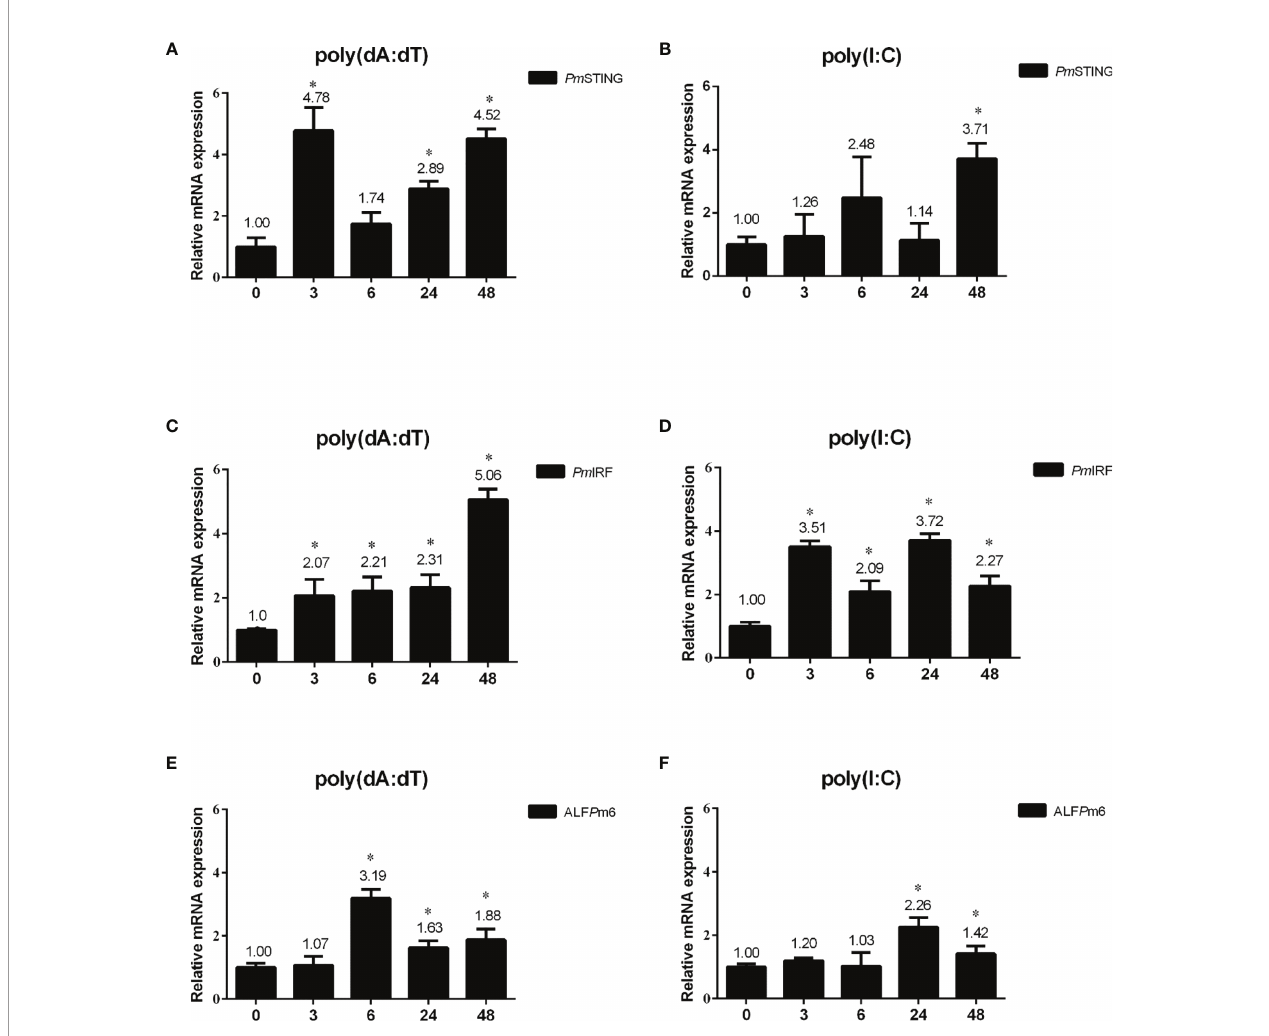
FIGURE 3 | Expression pro fi les of immune-related genes in P. monodon intestine after injection of nucleic acid mimics. (A – F) Relative expression levels of Pm STING (A, B) , Pm IRF (C, D) , and ALF Pm 6 (E, F) were evaluated by qRT-PCR at 0, 3, 6, 24, and 48 h after injection of poly(dA:dT) or HMW poly(I:C), with the EF1- a gene serving as an internal control. The expression level at 0 h was set as the baseline (1.0). Data represent mean ± SD of the assay performed with triplicate samples. *p <